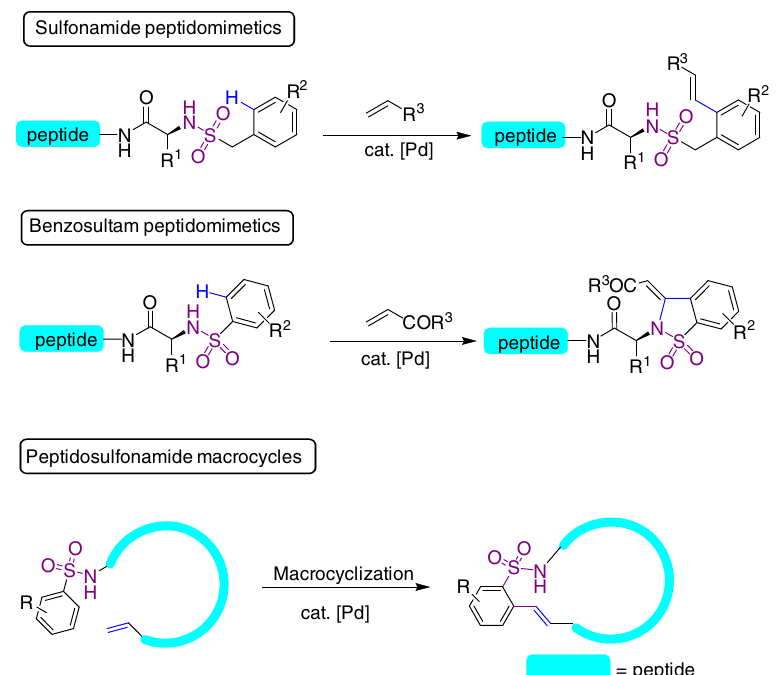
Fig. 1 Synthesis of peptidomimetics containing aryl sulfonamide motif. a Bioactive benzylsulfonamide and benzosultam-containing peptidomimetics. b Peptide-guided functionalization and macrocyclization of sulfonamide-containing peptidomimetics by Pd(II)-catalyzed late-stage C – H activation. HAT human airway